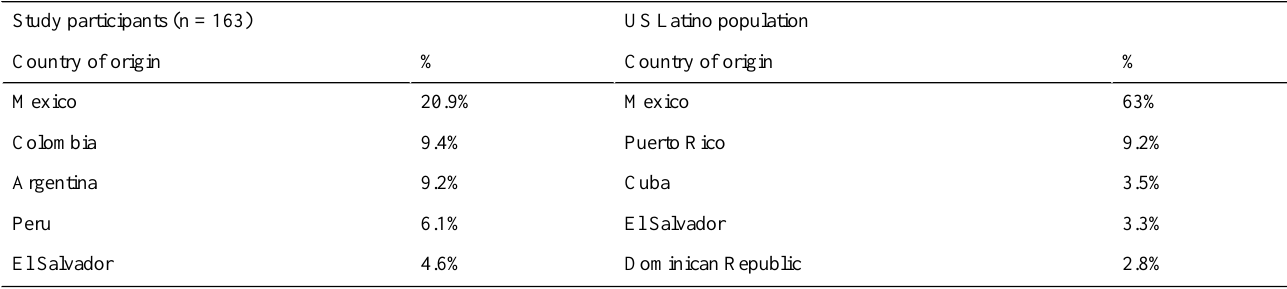
Table 1. Most frequent countries of origin for native Spanish-speaking participants versus the US Latino population.